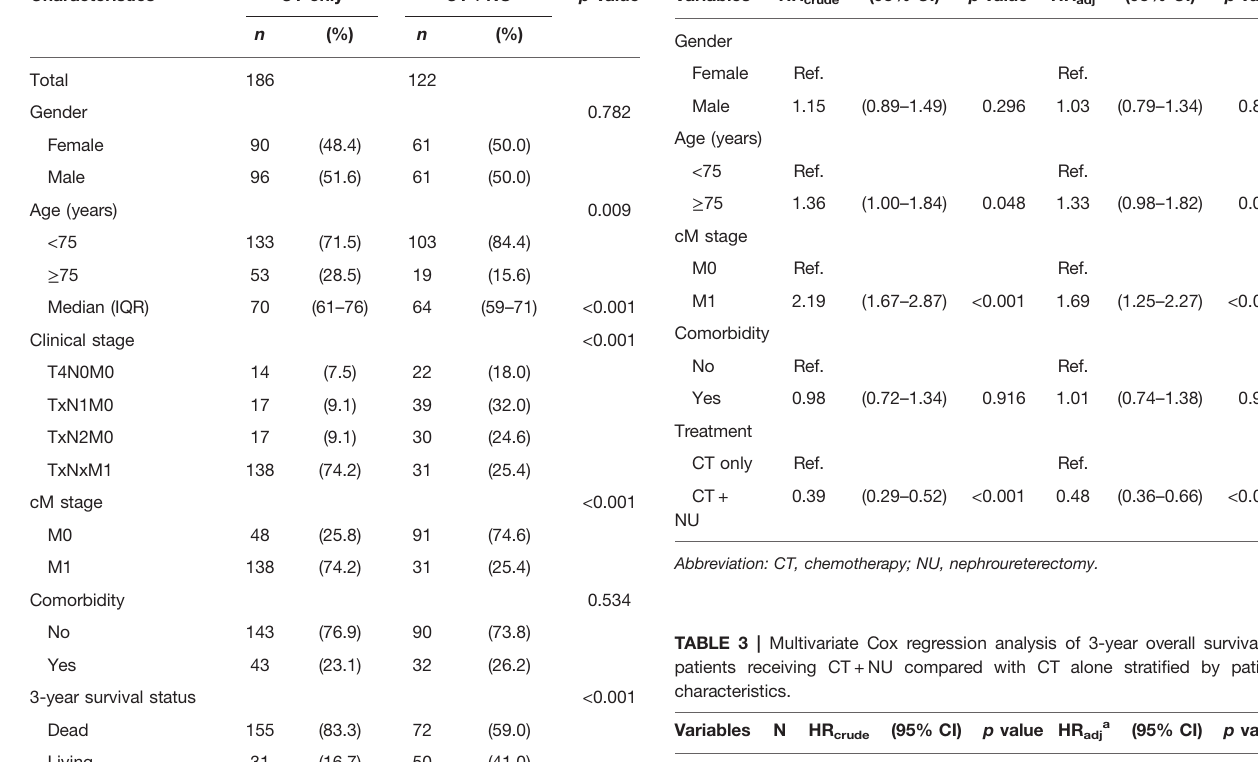
TABLE 1 | Baseline characteristics of patients with stage IV upper urinary tract urothelial cancer who underwent CT alone or CT+NU. Characteristics